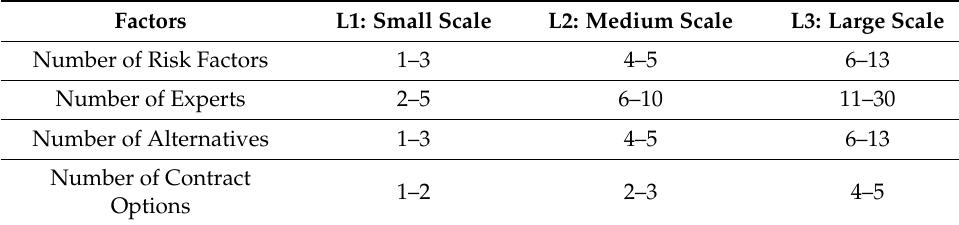
Table 6. Experiments for verification section.